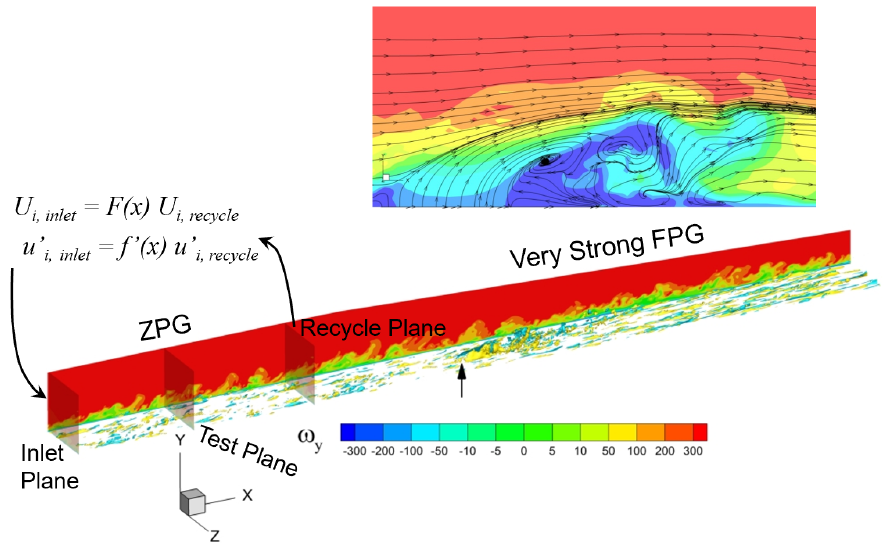
Figure 2. Schematic of the spatially-developing boundary layer with inlet, recycle and test planes about 60 δ inl in streamwise length. The top view shows a close-up of the crossflow